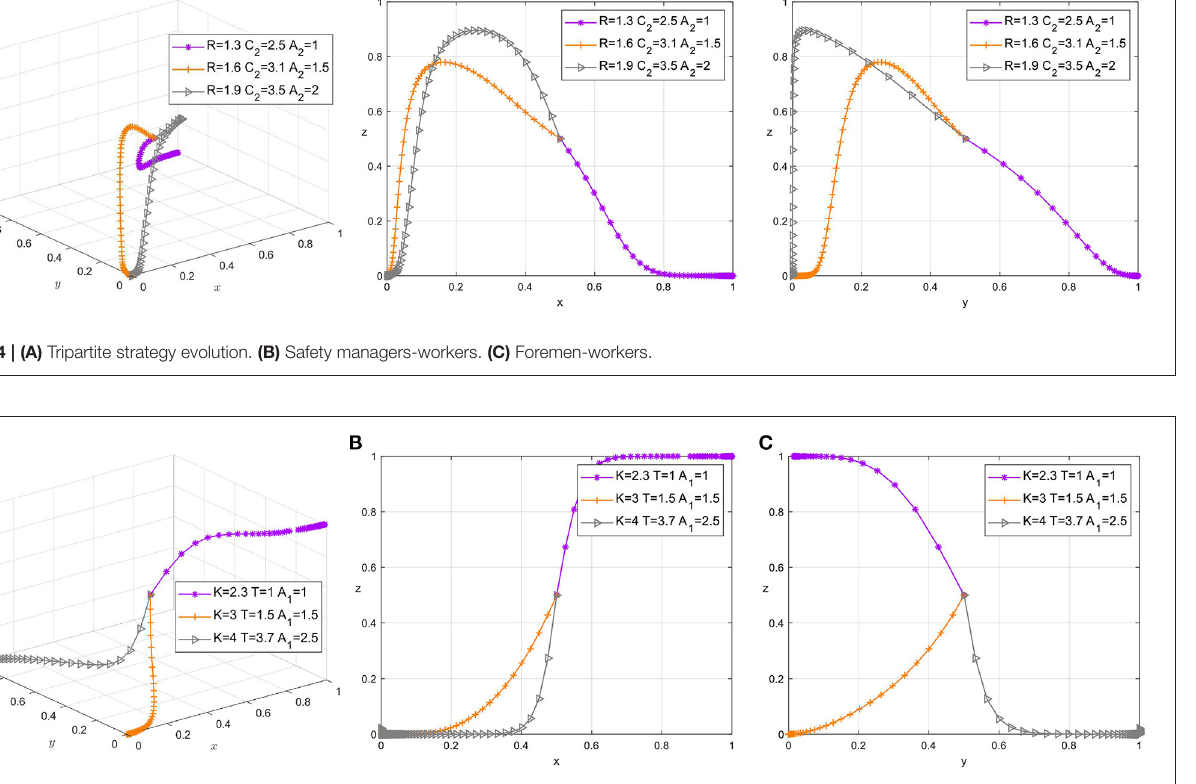
FIGURE 5 | (A) Tripartite strategy evolution. (B) Safety managers-workers. (C) Foremen-workers. points: S 1 (0, 0, 0), S 2 (0, 0, 1), S 3 (0, 1, 0), S 4 (1, 0, 0), S 5 (1, 1, 0), S 6 (1, 0, 1), S 7 (0, 1, 1), S 8 (1, 1, 1). In the post-workgroup